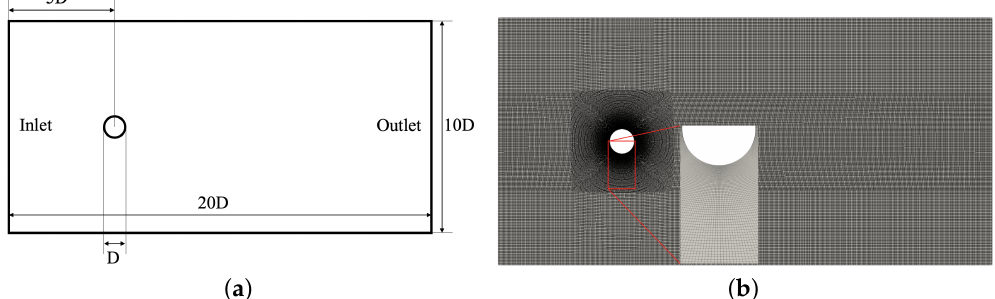
Figure 1. ( a ) The computational domain ( D = 0.1 m) and ( b ) the numerical mesh. The numerical mesh contains 171,864 points, 341,532 faces (169,668 internal faces), 85,200 cells, and 7 boundary patches, and the cells are all hexahedrons.